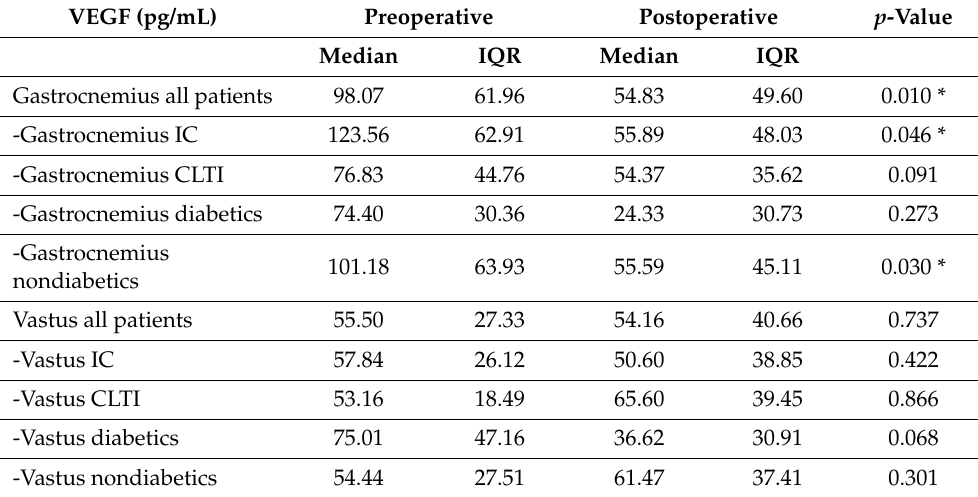
Table 2. VEGF levels in biopsies of vastus lateralis muscles (non-ischemic) and gastrocnemius muscles (ischemic) before and after revascularization. p -values were calculated using a Wilcoxon test for paired samples. An asterisk indicates p < 0.05. IQR: interquartile range. PAD: peripheral artery disease. IC: intermittent claudication. CLTI: chronic limb-threatening ischemia.